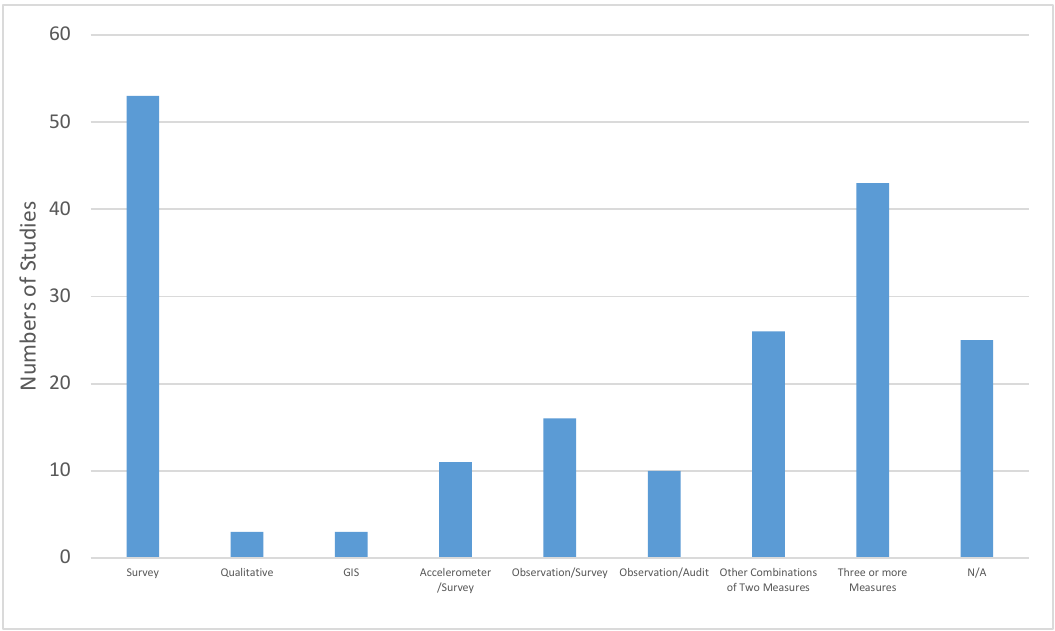
Figure 4. Countries/Continents on which the studies considered in this review were carried out. Figure 4. Countries / Continents on which the studies considered in this review were carried out. Reviews were categorized as not applicable (N/A.). Reviews were categorized as not applicable (N / A). Int. J. Environ. Res. Public Health 2020 , 17 , x